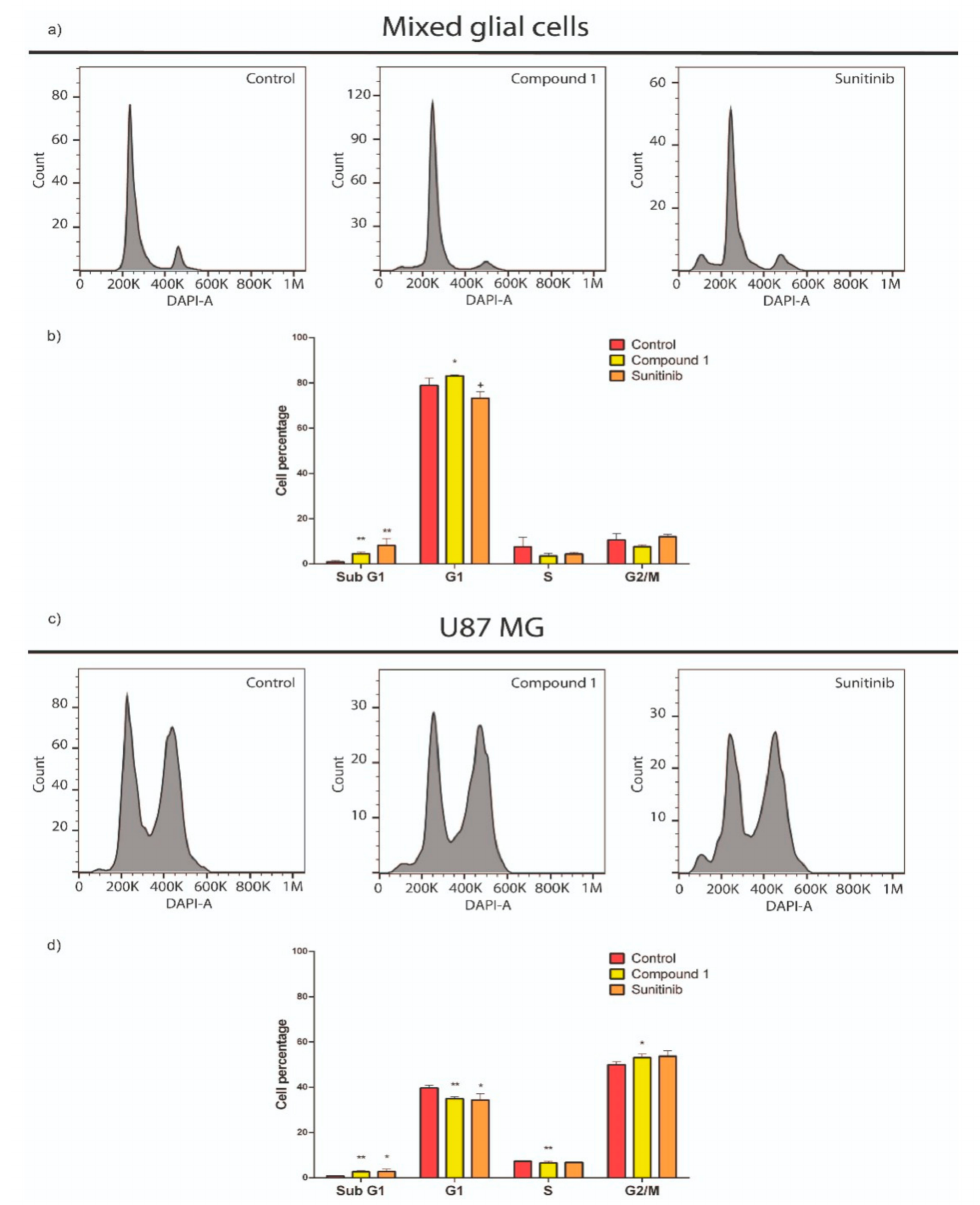
Figure 6. E ff ects on cell cycle in mixed glial cells ( a,b ) and U87 MG cells ( c,d ) treated with compounds 1 or Sun . Values correspond to the averages ± SEMs of three independent experiments. Cell debris was omitted from analyses; 10,000 events were analyzed per sample. ** p < 0.05, * p < 0.1, + p = 0.1245, when compared to the negative control group by multiple